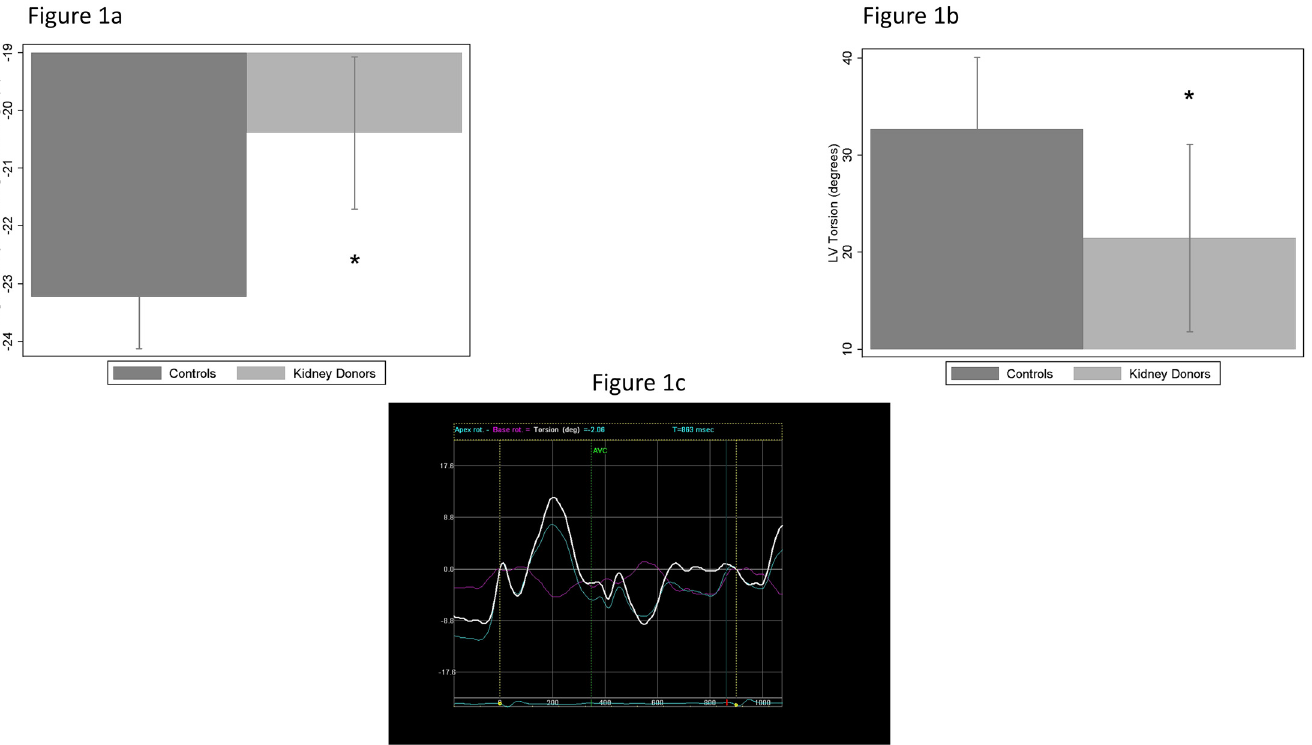
Fig 1. Bar graph showing mean ( ± SD) of different speckle myocardial imaging modalities in kidney donors (n = 15) and controls (n = 15). (a) Longitudinal systolic strain, global average of 18 LV segments, in the 2 groups under study; star = p < 0.05 for the comparison between kidney donors and controls (Mann-Withney Test). (b) Left ventricular torsion in the 2 groups under study; star = p < 0.05 for the comparison between kidney donors and controls (Mann-Withney Test). (c) Example of a typical curve showing LV torsion rate (degrees/sec, positive wave) and de-torsion rate (early: first negative wave, late: second negative wave) obtained on a healthy subject with the GE ECHOPAC